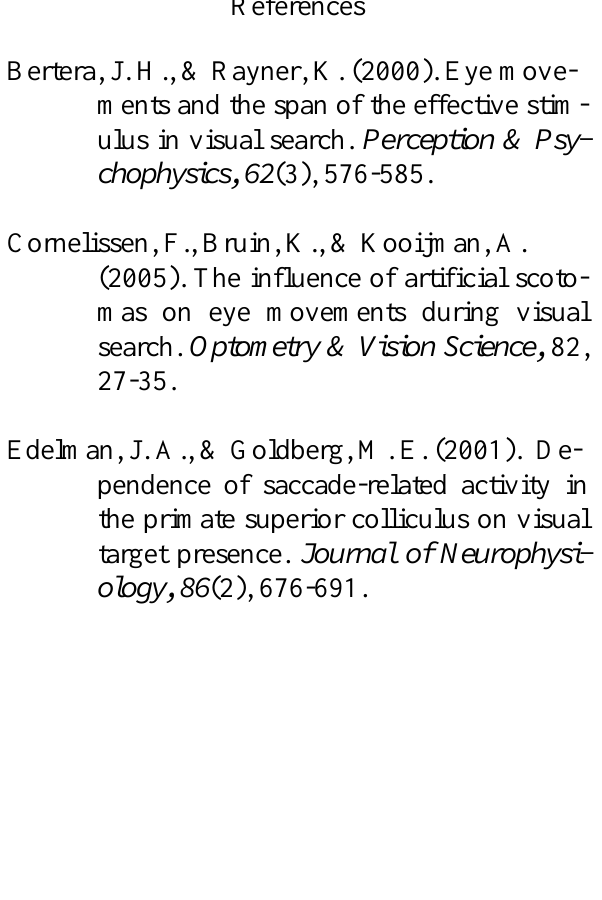
Functional differences in visual search fixation